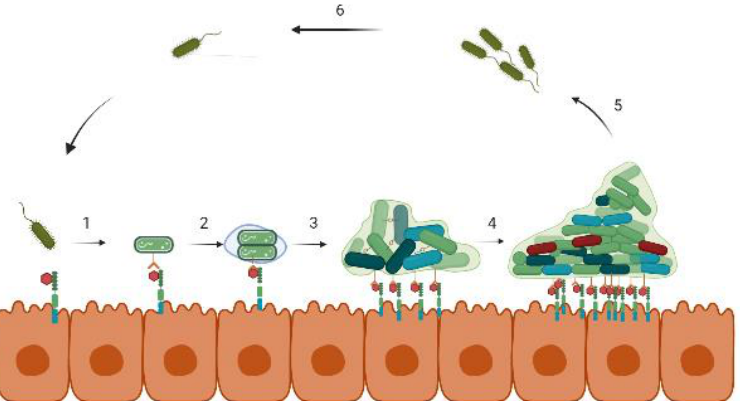
Figure 1. Stages of biofilm formation on a biotic surface. (1) Bacteria approach the host cells and bind to specific receptor proteins. (2) After binding, bacteria start multiplying and secrets EPS that (3) eventually forms the microcolonies, and (4) the biofilm develops into a more complex 3D structure. In (5) and (6), the cycle, thus, continues with the dispersion of bacteria from the biofilm.